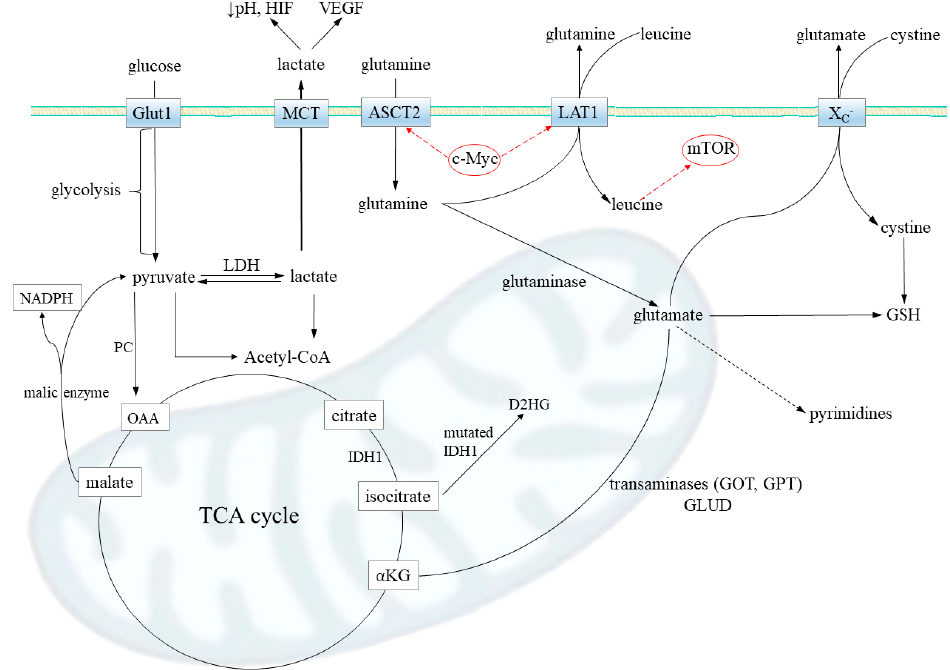
Figure 2. Metabolic pathways contributing to glutamine addiction in gliomas. Firstly, glutamine transport via Slc1a5 transporter (ASCT2) is increased in gliomas. The promoters of the Slc1a5 gene are under transcriptional control of oncogenic transcription factor c-MYC, which upregulates its expression. A substantial portion of intracellular glutamine is released from the cell via transporter LAT1 (Slc7a5; also upregulated by c-MYC) in exchange for extracellular leucine, an essential amino acid. The glutamine–leucine shuttle directly activates mTOR signaling, leading to increased protein synthesis. That way, an abundance of glutamine further accelerates the glioma anabolism. When in the cell, glutamine may be converted by glutaminase to glutamate, which is then metabolized to (i) alpha-ketoglutarate ( α KG) (by transaminases GPT and GOT or glutamate dehydrogenase, GLUD) and serves for tricarboxylic acid (TCA) cycle anaplerosis; the reaction catalyzed by pyruvate carboxylase (PC), generating oxaloacetate (OAA) from pyruvate, is downregulated in most neoplasms; (ii) oncometabolite D-2-hydroxyglutate (D2HG) in the case of mutations in IDH1 enzyme, leading to a loss of proper enzymatic activity; iii) antioxidant glutathione (GSH), responsible for the treatment resistance; transporter XC- performs antiport of glutamate and cystine, which is a limiting substrate in GSH synthesis; and iv) lactate, which may be a source of energy when glutaminolysis